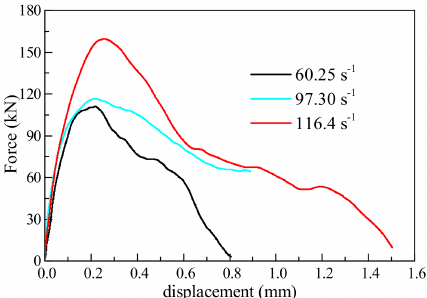
Figure 6. Force-displacement curves for concrete at different strain